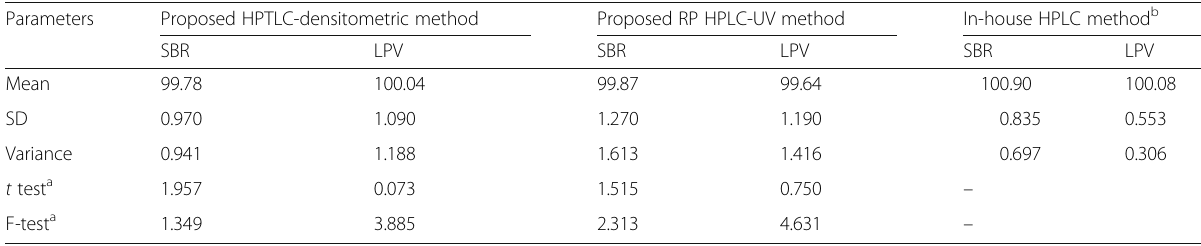
Table 7 Results of statistical comparison a between the developed chromatographic methods and reported HPLC method (Rote et al. 2017) used for the simultaneous determination of SBR and